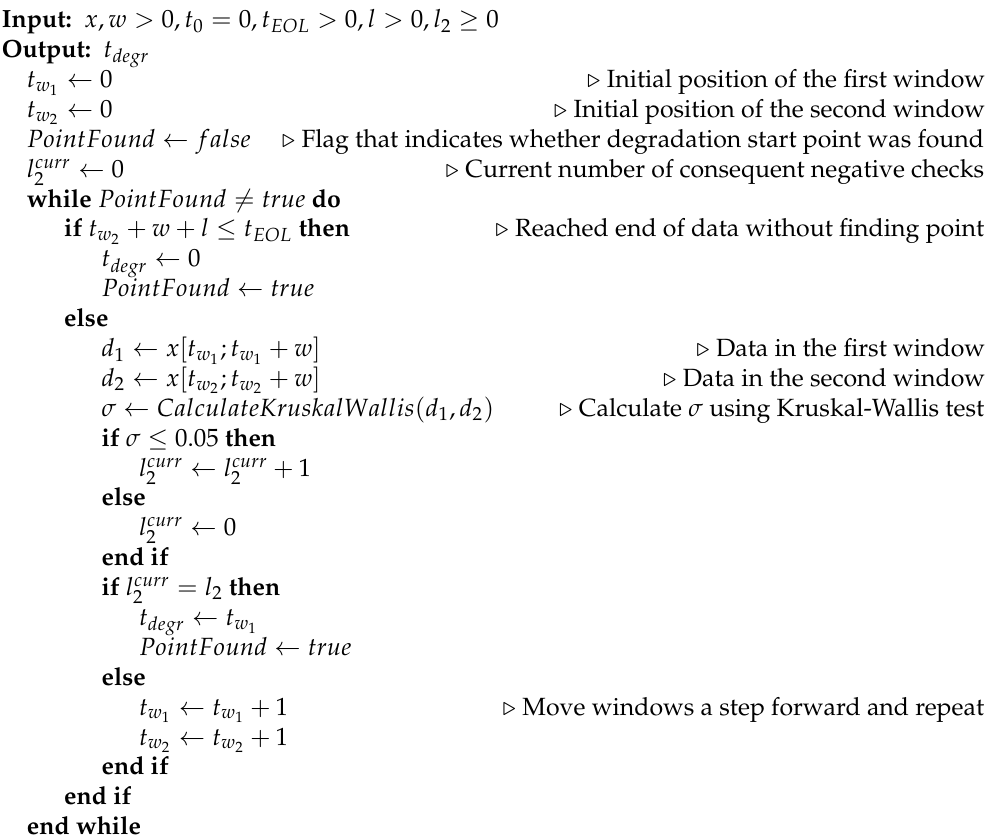
Algorithm 1 Determining degradation start point using HMHM